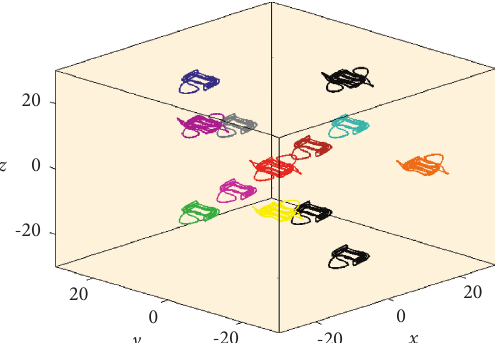
Figure 19: A 3D grid of a variable periodic and chaotic attractors ,q ,q ] � [ 0 . 80 , 0 . 90 , 0 . 91 ] with a � 1 and b � − 9 for when [ q 1 2 3 ( m, n,k ) � ( 0 , 0 , 0 ) ,